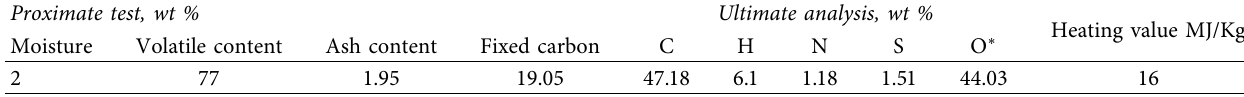
Table 1: Proximate and ultimate test of peanut shell